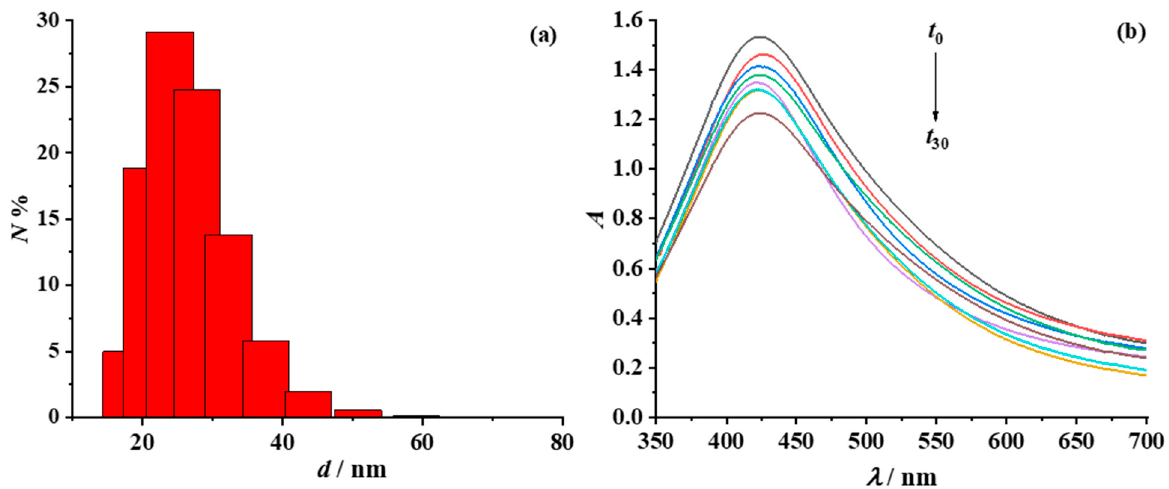
Figure 9. ( a ) Particle size distribution for conductive ink with 10 wt% amphiphilic silver particles and ( b ) the corresponding UV-Vis absorption spectra, recorded during a testing period of one